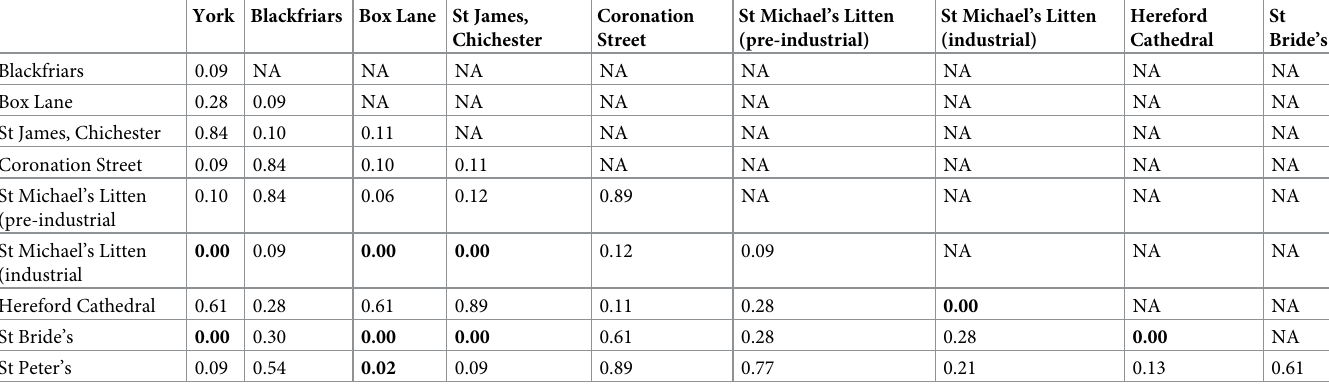
Table 6. Results of post-hoc pairwise comparison using permutational MANOVA of wear facet area between the skeletal assemblages examined.